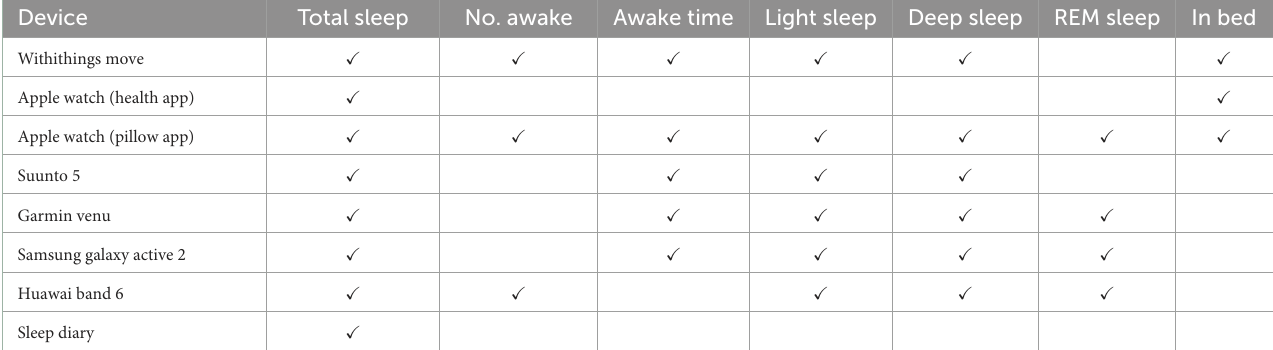
TABLE 1 Overview functional differences in used devices.